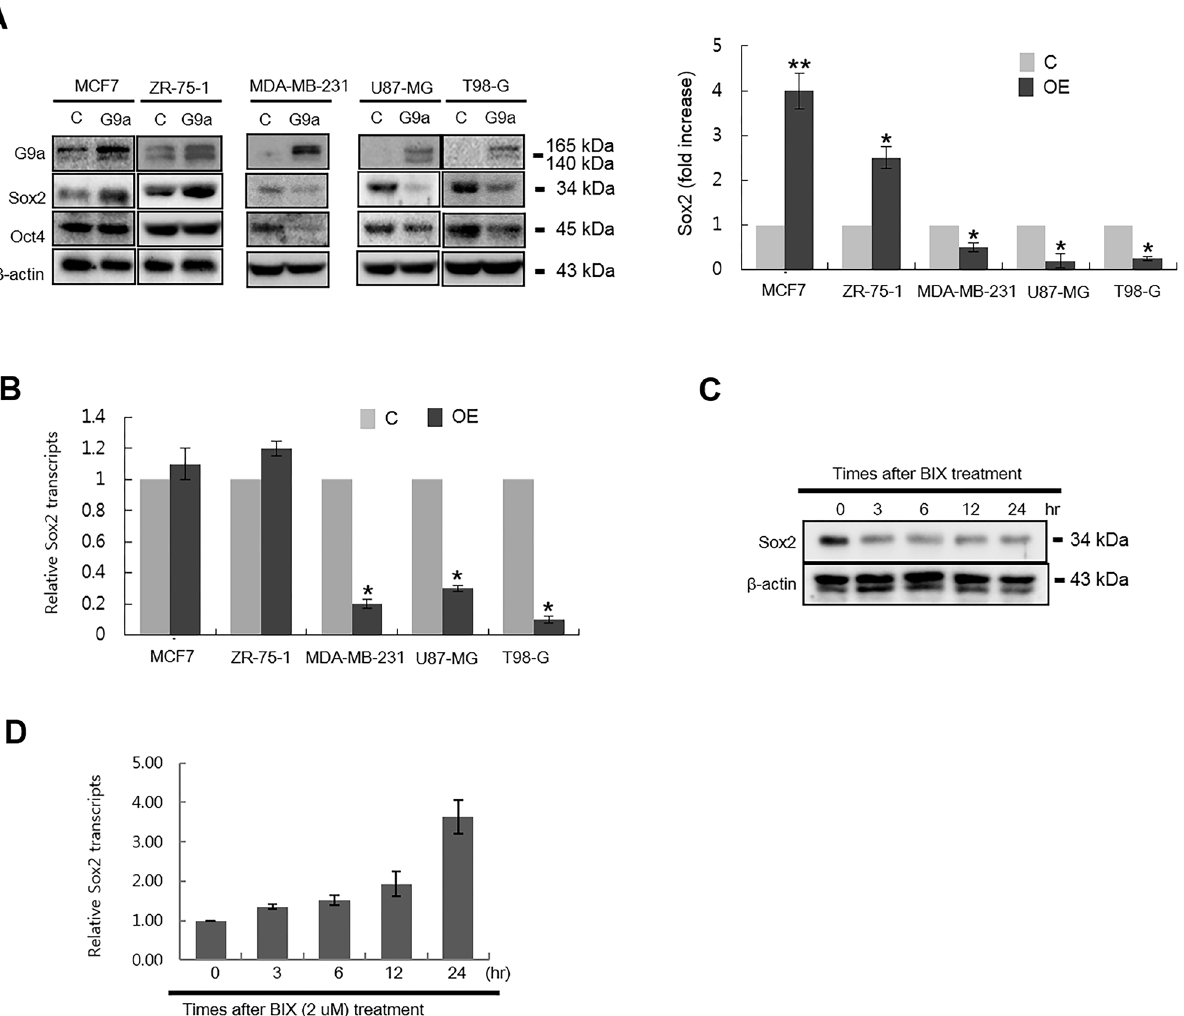
Fig 4. Effect of G9a on the transcription and protein expression of Sox2 in various cell types. (A) The effect of ectopic expression of G9a on Sox2 and Oct4 protein expression in three breast cancer cell lines (MCF7, ZR-75-1, and MDA-MB-231) and two glioblastoma cell lines (U87-MG and T98-G) was determined by immunoblot analysis. Each cell line was transfected with a G9a-expressing plasmid for 24 h and then harvested for analysis. For quantitative analysis of immunoblotting results, the mean density of the Sox2 band was measured with Multi Gauge V3.0 software, and the band density was divided by the density of β -actin to obtain the normalized band density. (B) Cells were transfected with control or G9a expressing plasmids for 24 h, and the effect of ectopic expression of G9a on the transcription of Sox2 was quantitatively analyzed by real-time RT-PCR. (C) The effect of G9a activity on Sox2 protein stability in mouse ESCs. Mouse ESCs were treated with 0.2 μ M BIX-01294 for the indicated times and then harvested for immunoblot analysis. (D) The effect of G9a activity on the transcription of Sox2 in mouse ESCs. Mouse ESCs were treated with 0.2 μ M BIX-01294 for the indicated times and then harvested